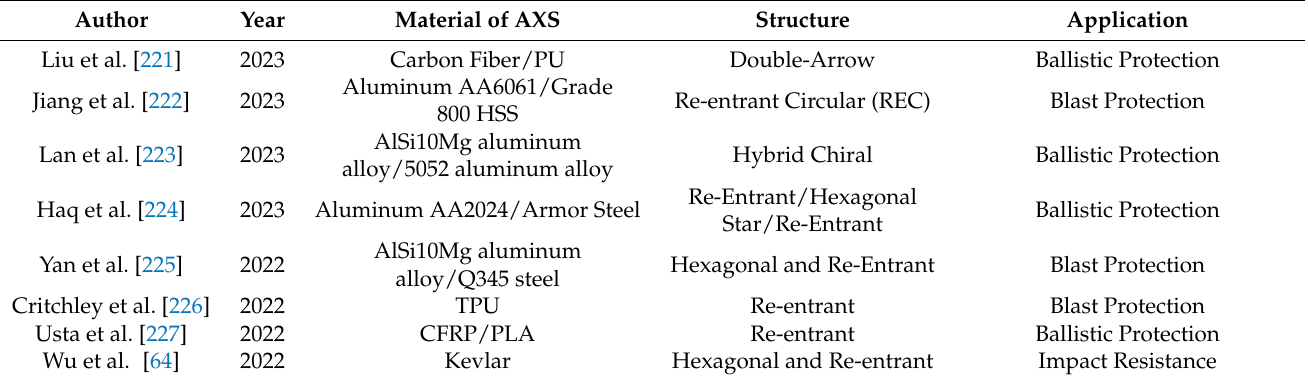
Table 4. Summary of recent papers discussing the auxetic sandwich panels for anti-blast and ballis- tic